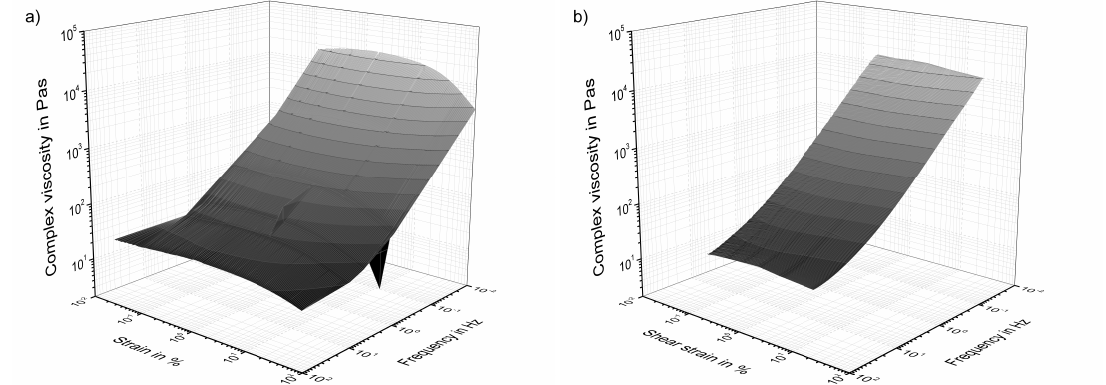
Figure 3. 3D visualization of complex viscosity development for 0.5wt% NC7000 dispersed in Epikote 828LVEL gathered from ( a ) strain-sweeps at different frequencies and ( b ) frequency-sweeps at different strain